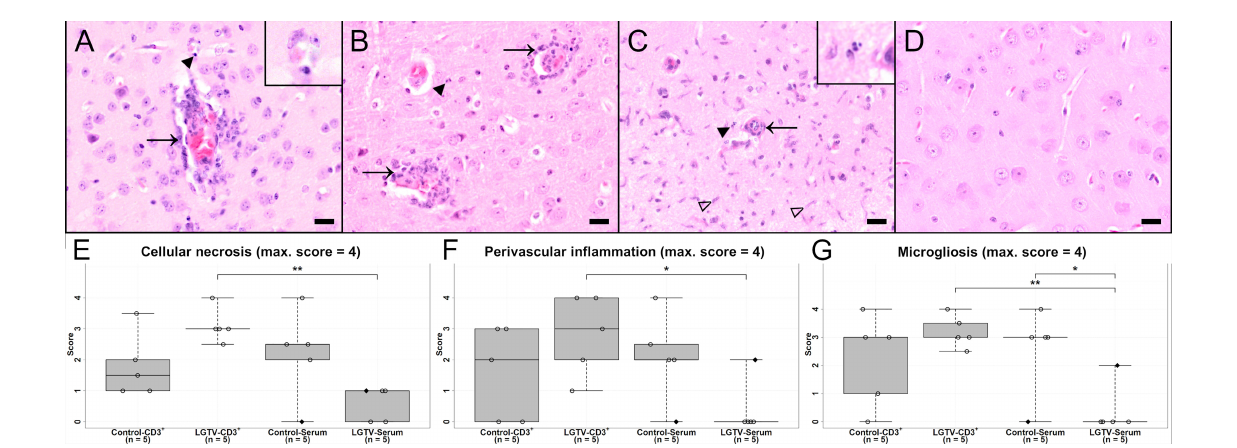
FIGURE 6 H&E stained sections of cerebral cortex of one representative mouse from each group (A) CD3 + T cell transfer from control donors; (B) CD3 + T cell transfer from LGTV infected donors; (C) serum transfer from control donors; (D) serum transfer from LGTV infected donors. In (A – C) signs of in fl ammation with in fi ltration of damaged blood vessels with in fl ammatory cells (arrow, (A) , (B) ), perivascular in fl ammation as well as cell necrosis (arrowhead and inserts) and microgliosis (blank arrowhead, (C) ) are visible. In the cerebral cortex of the mouse that had received serum from LGTV infected donors, no histopathological changes are observed (D) . Scale bars: 20 µm. (E – G) display box plots of the scoring values for “ cellular necrosis ” (E) , “ perivascular in fl ammation ” (F) and “ microgliosis ” (G) of cerebral cortex for each experimental group. Signi fi cant differences detected by pairwise Wilcoxon rank-sum tests after non-parametric ANOVA and multiple testing adjustment are indicated by asterisks (* p < 0.05; ** p< 0.01). Mice that differed in their clinical state from other mice in the control and LGTV serum recipient group are highlighted as rhombus shaped dots in the box